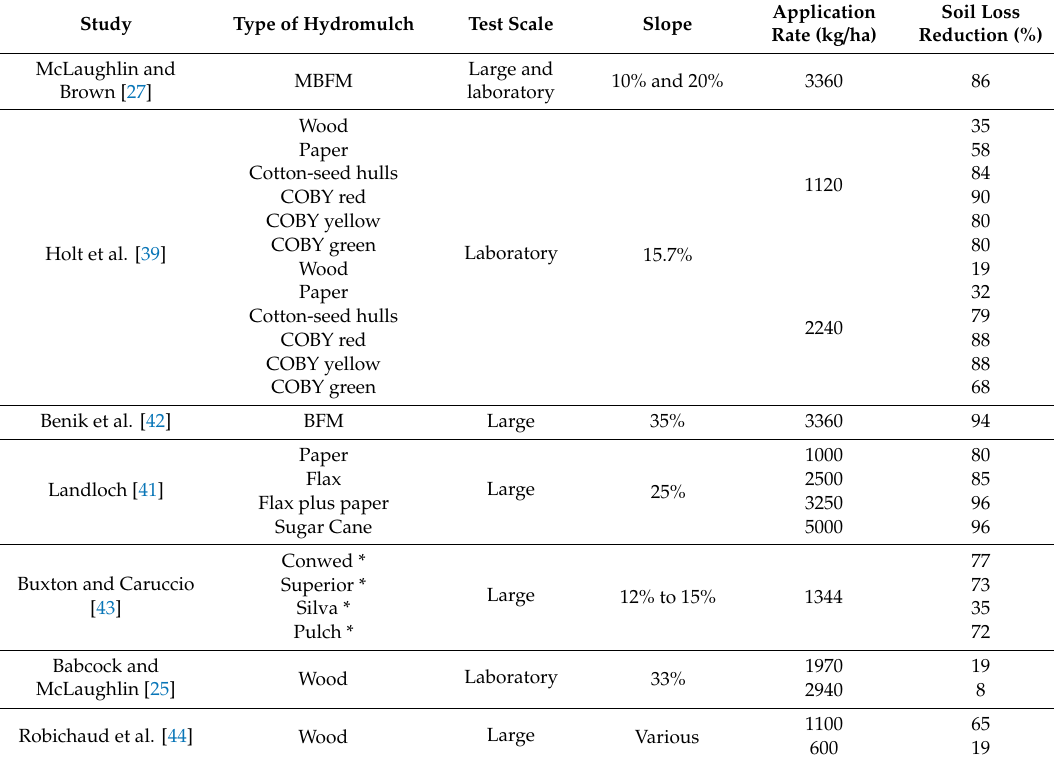
Table 1. Summary of reviewed hydromulch